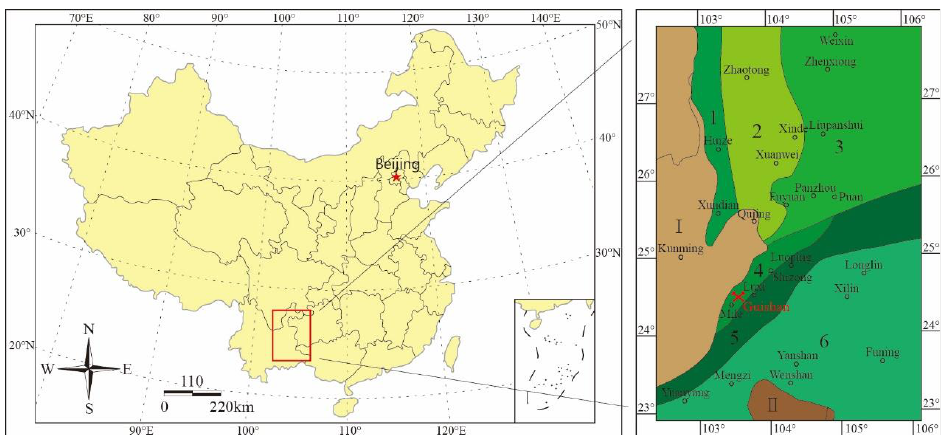
Figure 1. Location of research area and the sedimentary environment in the Late Permian. Note: Yellow areas are eroded areas. Part I is the Kangdian Oldland, and Part II is the North Vietnam Oldland. The green area represents the sedimentary area. Part 1 is a piedmont alluvial plain. Part 2 is a coastal alluvial plain. Part 3 is a coastal plain. Part 4 is a continental edge alluvial slope. Part 5 is a Lux – Luoping trough. Part 6 is a restricted carbonate platform. The mining symbol represents the location of the Guishan coalfield. This map is modified from that of Dai et al. [15]. The coal-bearing sequence of the Guishan coalfield is the Xuanwei Formation, which is mainly composed of sandstones, siltstones, and mudstones (Figure 2). There are 14 – 26 coal seams in the Guishan coalfield, and the average total thickness of all the coal seams is approximately 28 m. There are seven minable seams in this coalfield: C2, C3-Upper, C3- Lower, C4-Upper, C4-Lower, C4 + 1, and C5 (Figure 2). The average total thickness of the minable seams is approximately 19 m. In the Feilongma mine, the average thickness of C4-Upper coal seam is 2.4 m. In the Shipeng mine, the average thickness of C5 + 10 coal seam is 0.2 m. The coals of C4-Upper and C4 + 1 coal seam are composed of mainly durains and, to a lesser extent, clarains, whereas the coals of the other five minable seams consist of mainly clarains and, to a lesser extent, durains [19,20].